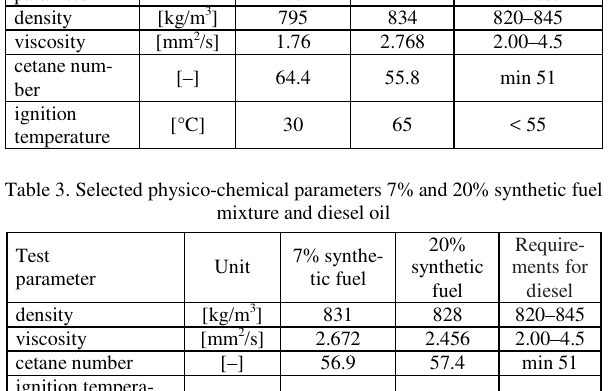
Table 2. Selected physico-chemical parameters of synthetic fuel and Test parameter